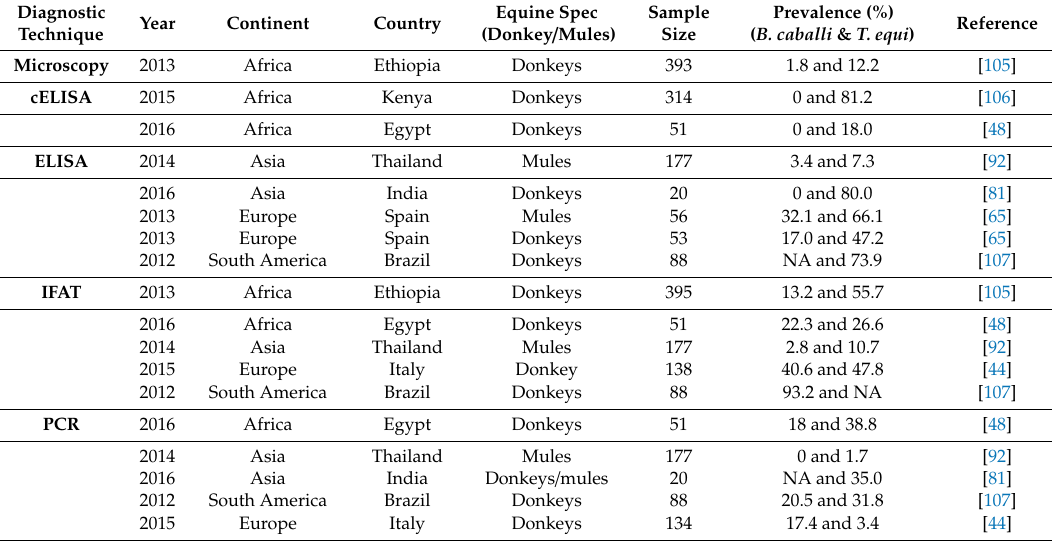
Table 2. Prevalence of equine piroplasmosis in donkeys / mules in endemic continents and countries using di ff erent diagnostic methods